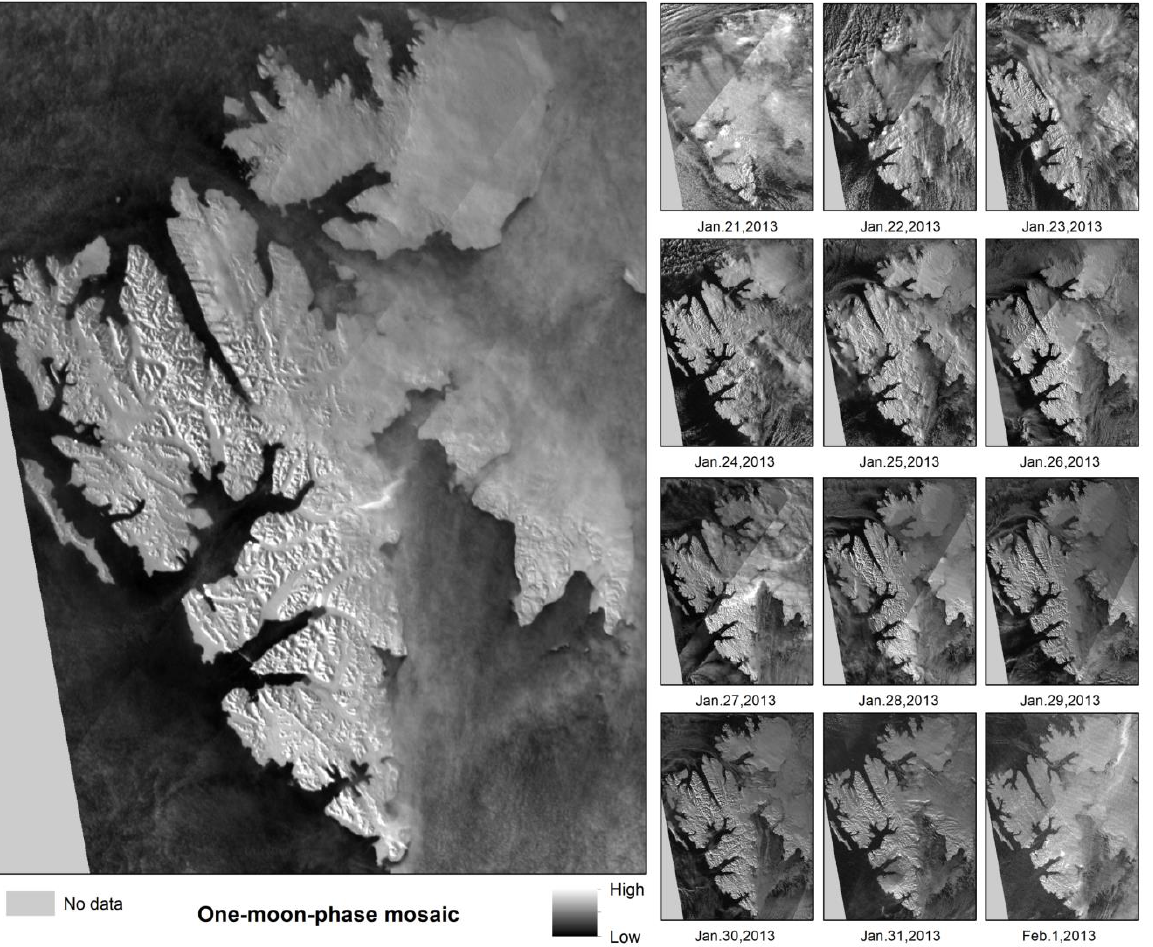
Figure 6. One-moon-phase mosaic image and every single lunar day image (lunar 10 December – 21 December 2012).